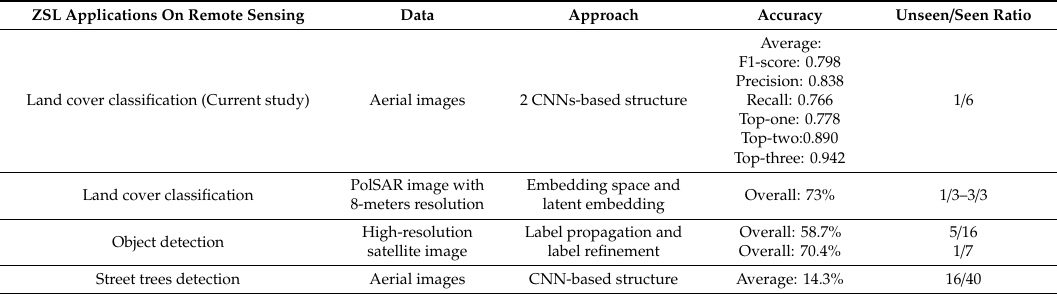
Table 13. Comparison of results from the previous studies and the current